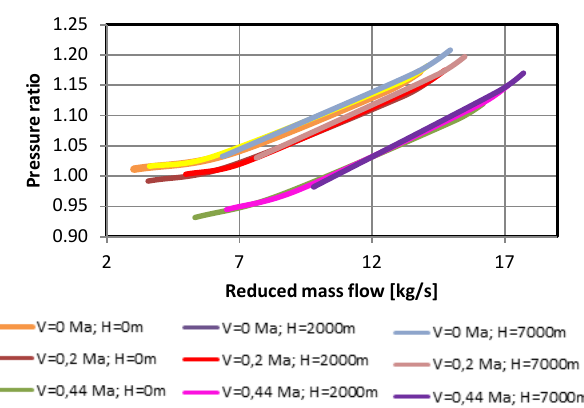
Fig. 3. Compressor map for fan of DGEN 380